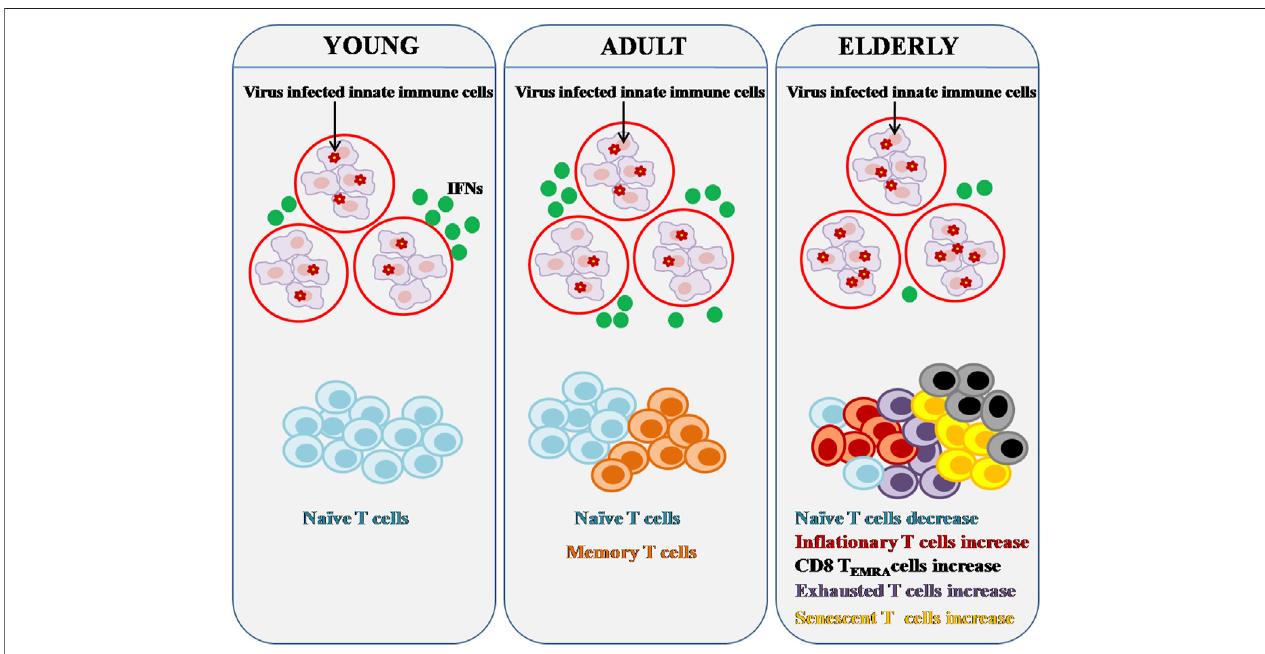
FIGURE 2 | Effect of Immunosenescence on chronic viral infection and immunity. Major components of both the innate and adaptive immune systems alter as people age. Innate immune cells can activate IFN pathways in response to viral infection in order to clear virus-infected cells. Reduced IFN production can be caused by age-related abnormalities in innate immune cells. Persistent viral infection can lead to signi fi cant changes in adaptive immunity, particularly T cell composition and function. There are fewer naive T cells in the aged, but there are more senescent, in fl ationary, and or exhausted T cells that are functionally inert or dormant.